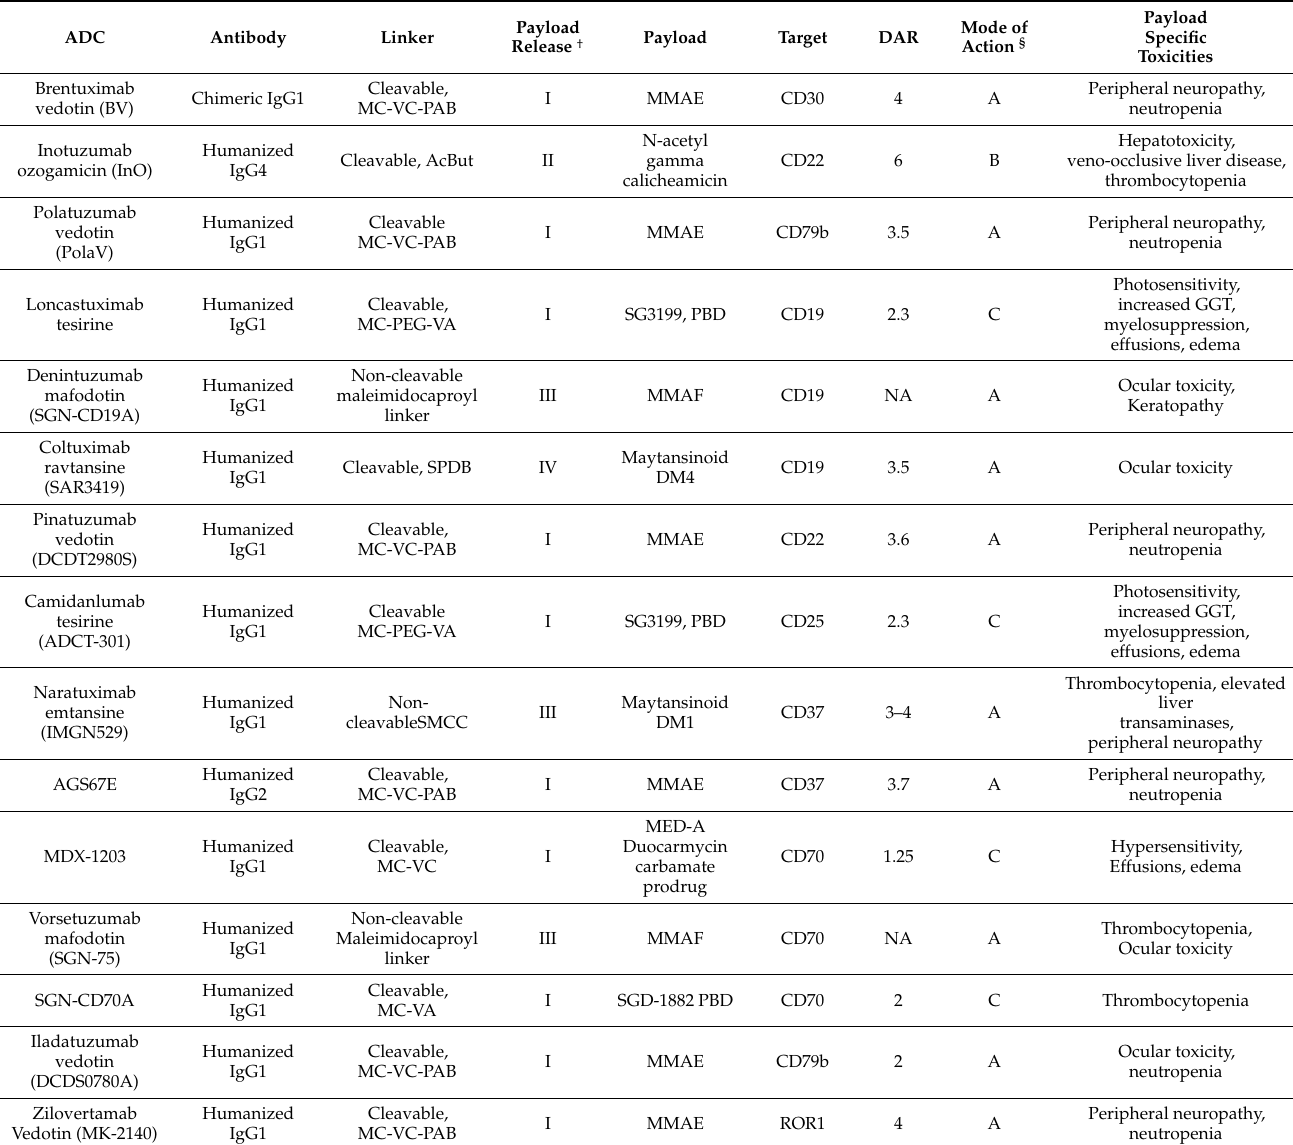
Table 3. Structure mechanism of action and key toxicities of commercially available and investiga- tional antibody-drug